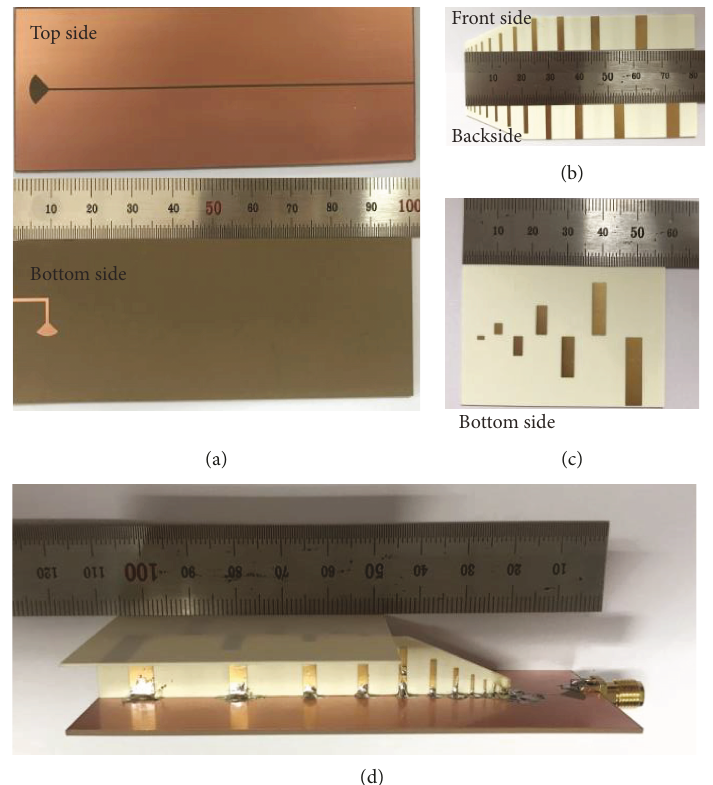
Figure 6: (a – c) The fabricated antenna components and (d) the assembled antenna.